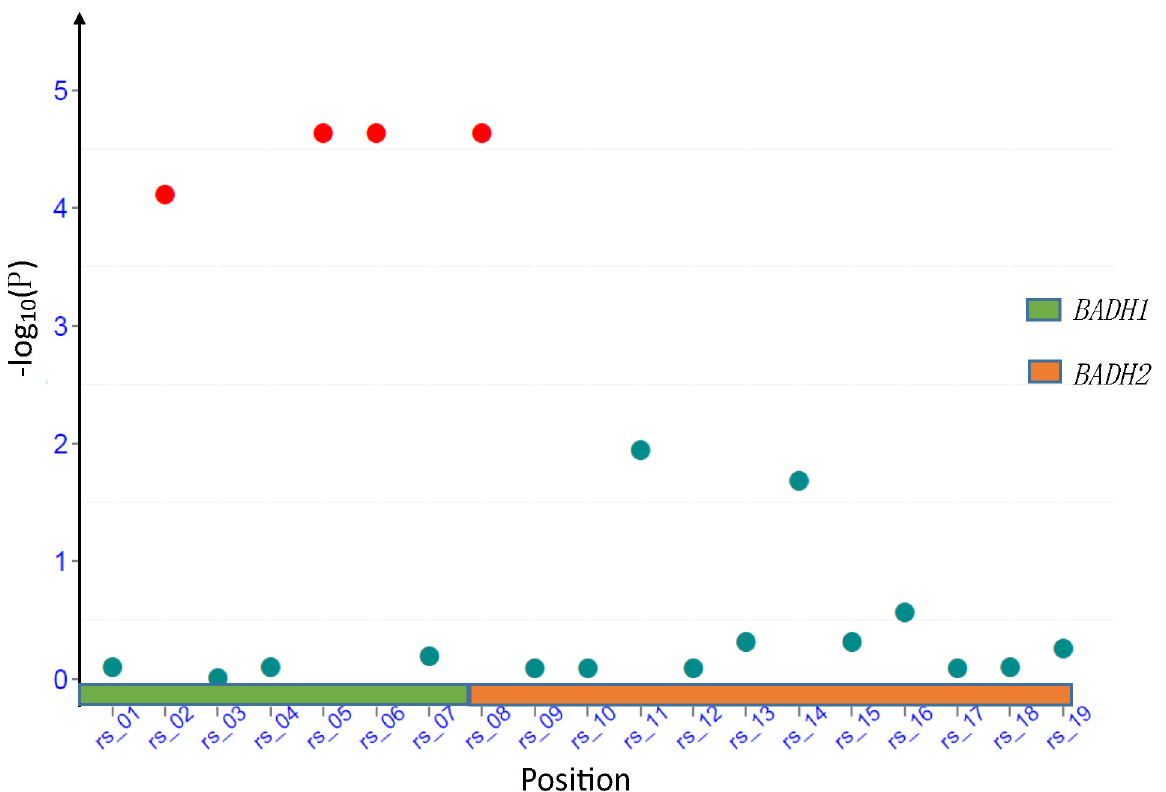
Fig 1. Associations across transcribed regions of BADH1 and BADH2